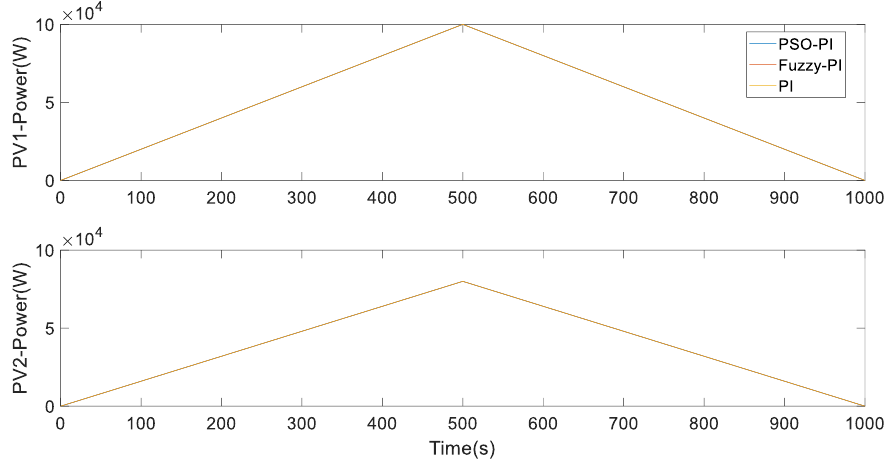
Figure 29. Output power of photovoltaic power generation unit in Example 3.